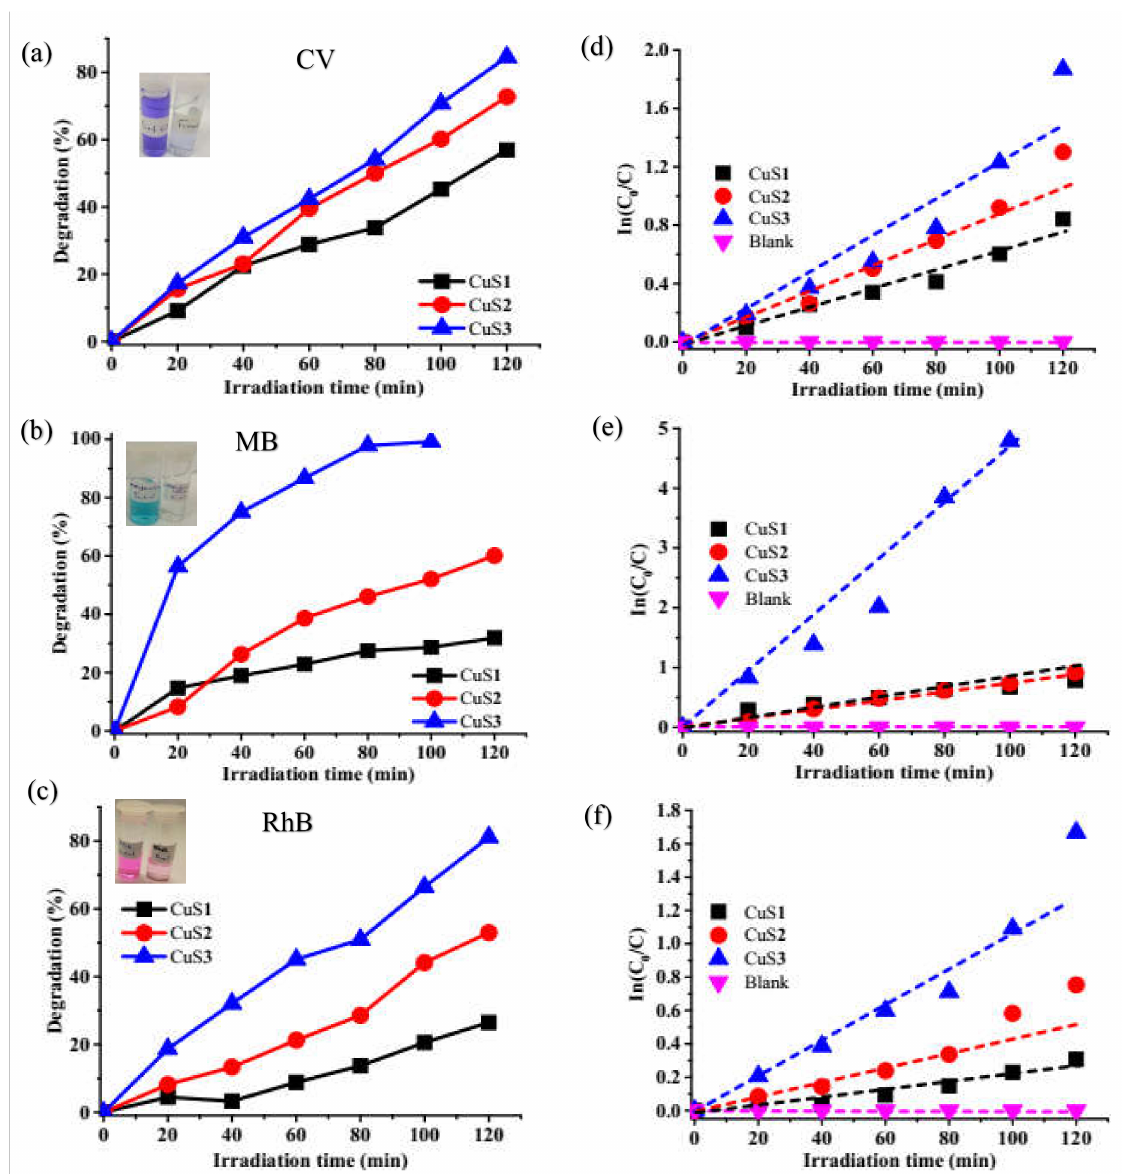
Figure 6. Degradation curve of organic dyes using CuS nanoparticles ( a – c ) and the corresponding plot of In(C 0 /C) versus irradiation time ( d – f